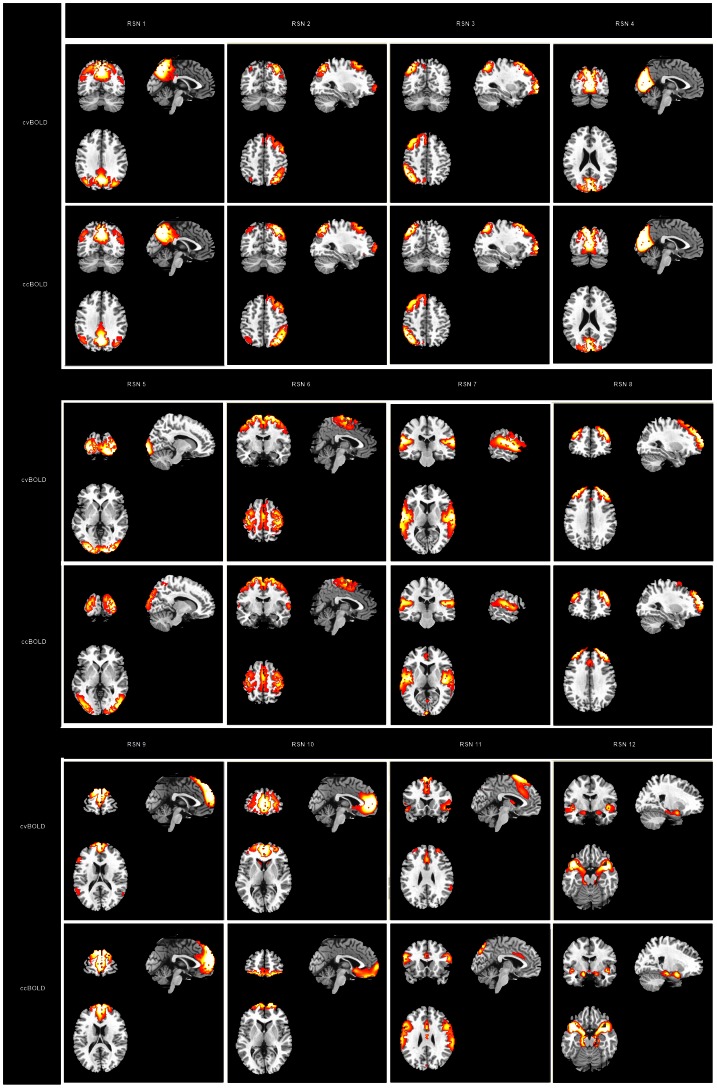
Resting-state networks (RSNs) identified from ICA analysis of conventional BOLD (up-levels) and concurrent BOLD (lower-levels) data.RSN1: default mode network (DMN); RSN 2: left attention networks; RSN 3: right attention network; RSN 4: primary visual network; RSN 5: secondary visual network; RSN 6: sensorimotor network; RSN 7: auditory network; RSN 8: executive network; RSN 9: dorsal medial prefrontal network (DMPFC); RSN 10: ventral medial prefrontal network (VMPFC); RSN 11: salience network, RSN 12: medial temporal limbic network.